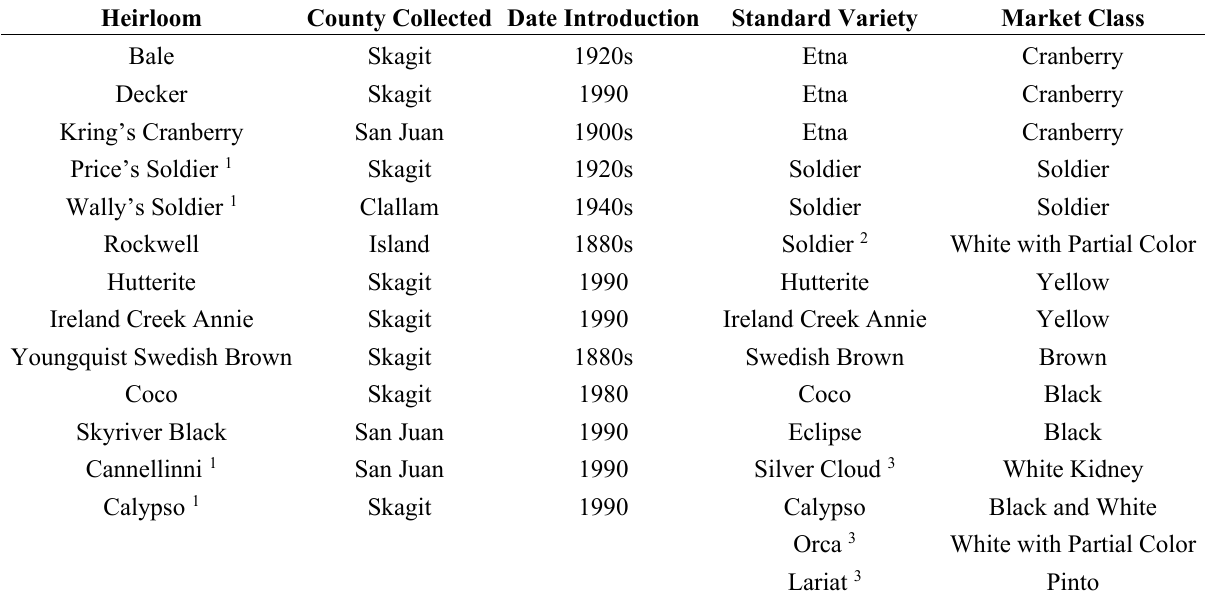
Table 1. Heirloom dry bean varieties collected from counties in northwest Washington, USA, the date each heirloom variety was first grown in the region and standard varieties in the same market